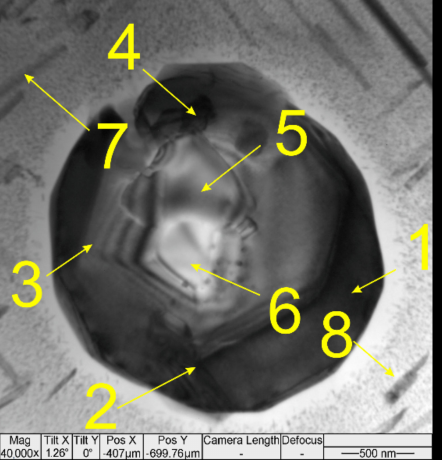
Figure 10. TEM image of a core-shell ν -phase+Mg 2 Si+Al-Zn-Cu-Mg particle in the AA4047/AA7075 transition